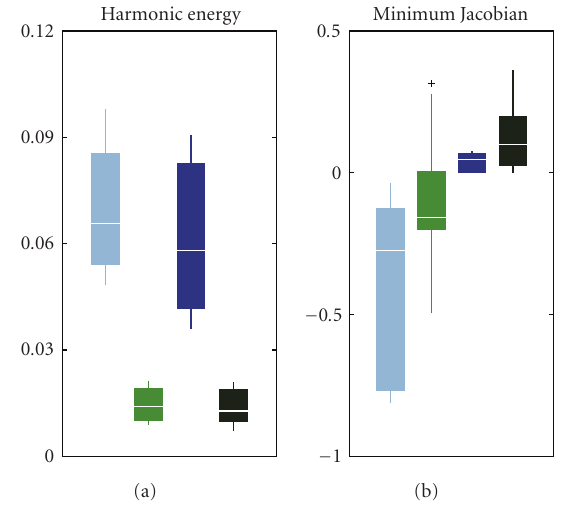
Figure 8: Results for the variable contrast experiment on 30 phases (3 patients with 10 phases each). (a) Boxplots of the energy of deformation after all 4 registrations. (b) Boxplots of the minimum Jacobian after all 4 registrations. From (a) to (b), these registrations are Demons (light blue), Morphons (light green), di ff eomorphic Demons (dark blue), and di ff eomorphic Morphons (dark green). For each box, the center horizontalline represents the median value, the box goes from the lower quartile to the upper quartile, and the vertical lines represent the most extreme values within 1.5 inter quartile range. The crosses represent outlier